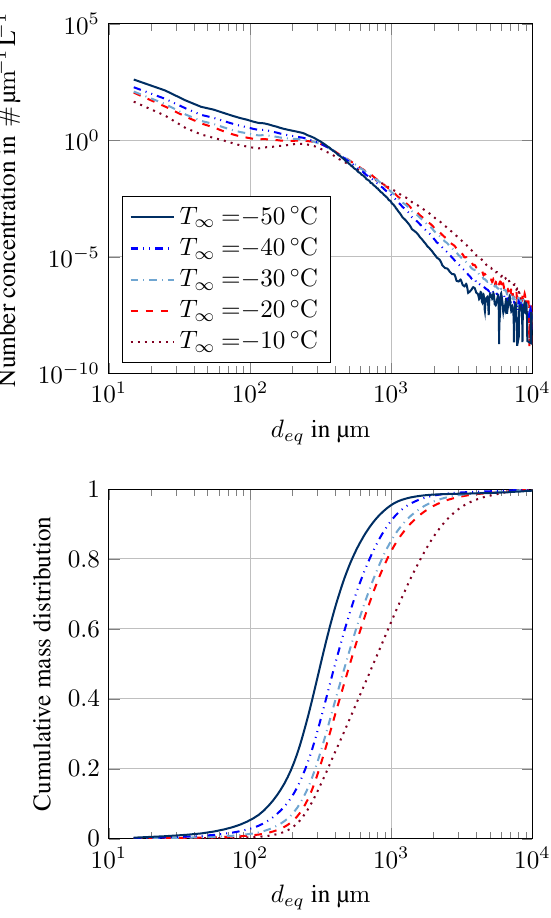
Figure 14. Ice particle size distribution (MMD) based on HAIC Falcon 20 flight measurements from Darwin and Cayenne in de- pendence of ambient air